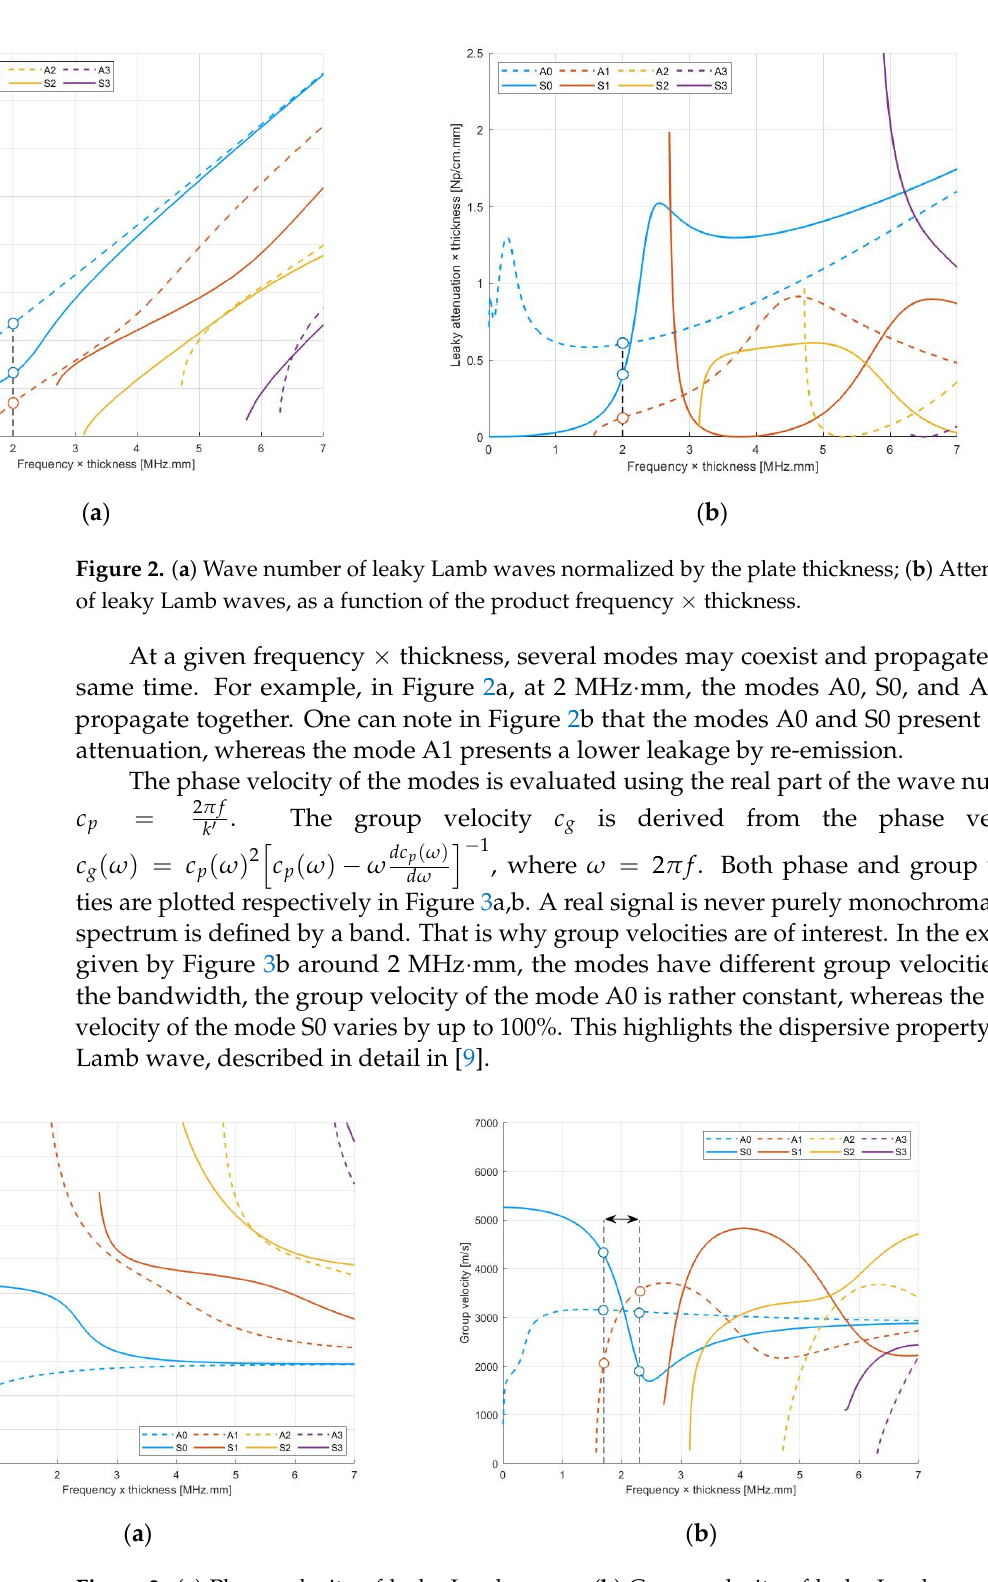
Figure 3. ( a ) Phase velocity of leaky Lamb waves; ( b ) Group velocity of leaky Lamb waves, as a function of the product frequency × thickness. Arrow indicates the bandwidth of a real 2 MHz · mm signal and highlights the dispersion phenomenon in the propagation of the Lamb waves.